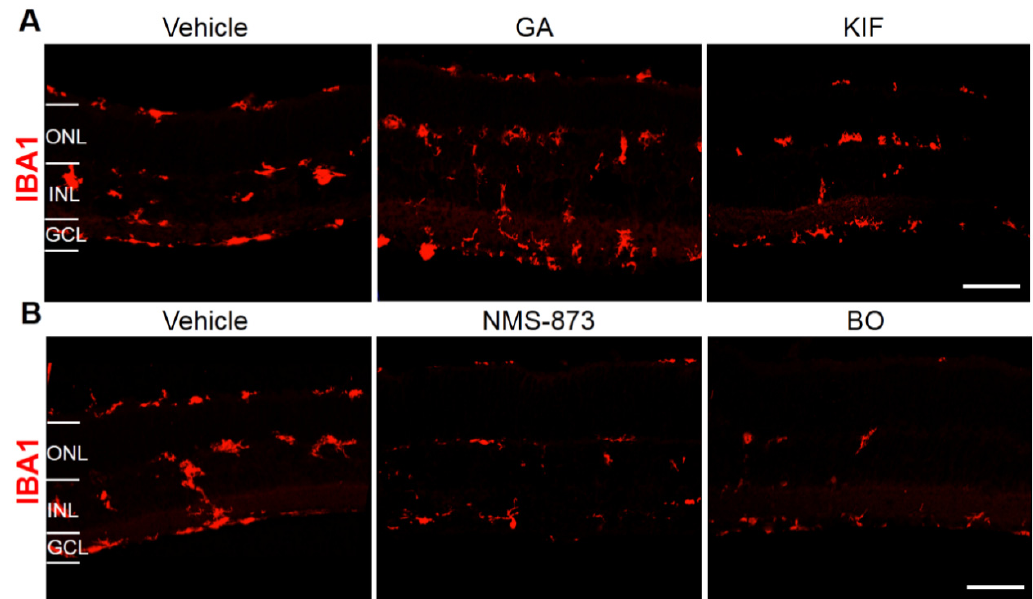
Figure 8. Pharmacological interference in the VCP/proteasome axis reduces retinal inflammation in RHO P23H retinal organotypic cultures. Fluorescent labeling in cryosections designates the location of Iba1 (red staining) in RHO P23H retinae organotypic cultures at PN15, explanted at postnatal day 9 and cultivated for 6 days (PN9 DIV6), treated with ( A ) corresponding vehicles (DMSO for GA or H 2 O for KIF), Hsp90 inhibitor GA (1 µ M), or ERM1 inhibitor KIF (100 µ M), and ( B ) corresponding vehicle (DMSO), VCP inhibitor NMS-873 (5 µ M), or proteasome inhibitor BO (1 µ M). Retinae treated with VCP or proteasome inhibitors but not with GA or KIF showed abated Iba1 activation. Scale bar is 50 µ m. ONL: outer nuclear layer; INL: inner nuclear layer; GCL: ganglion cell layer; GA: geldanamycin; KIF: kifunensine; BO: bortezomib; Iba1: ionized calcium-binding adapter molecule 1.